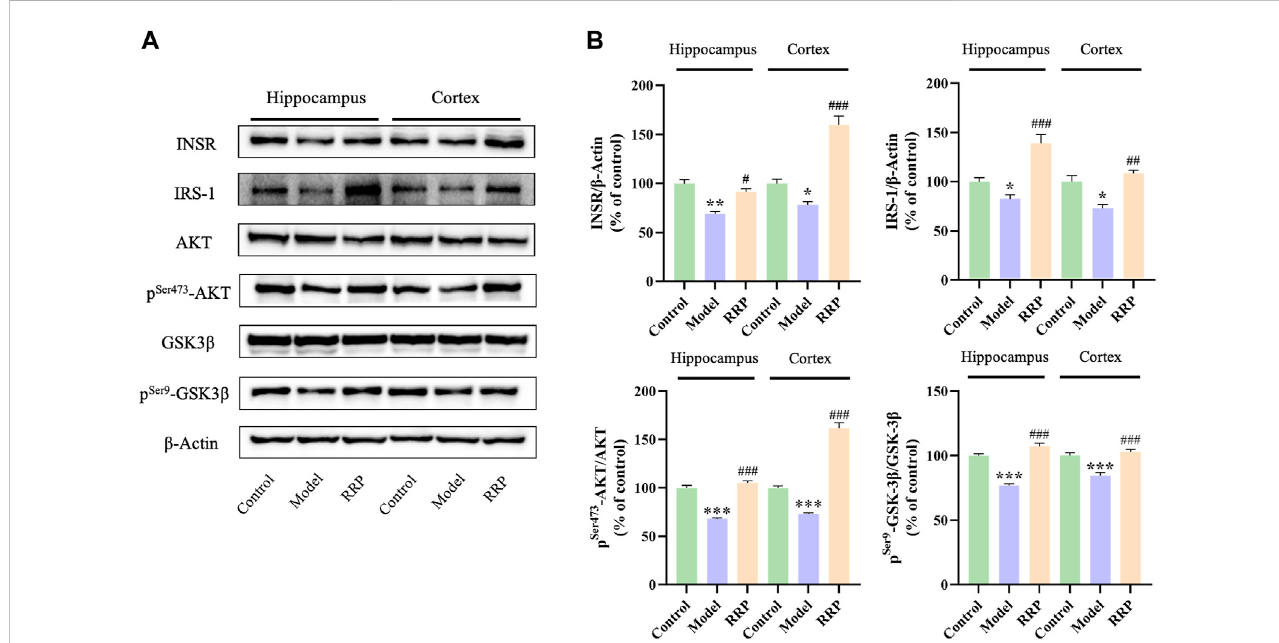
FIGURE 4 Western-blotofINSR,IRS-1,p Ser473 -AKT/AKT,andp Ser9 -GSK-3 β /GSK-3 β inhippocampusandcortextissuesofeachgroupofmice. (A) Electrophoresisof INSR, IRS-1, AKT, p Ser473 -AKT, GSK-3 β , p Ser9 -GSK-3 β in hippocampus and cortex tissues of each group of mice. (B) Protein expression levels of INSR, IRS-1, p Ser473 -AKT/AKT, and p Ser9 -GSK-3 β /GSK-3 β in hippocampus of mice in each group. Each bar with vertical line represents the mean ± SD of three mice per